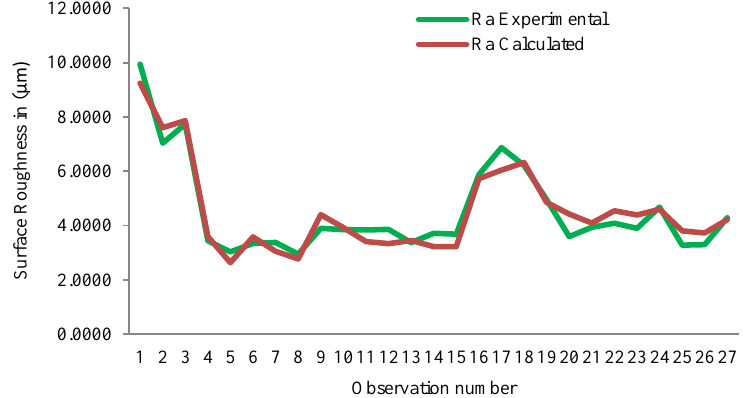
Fig. 7. Validation of Model for Surface